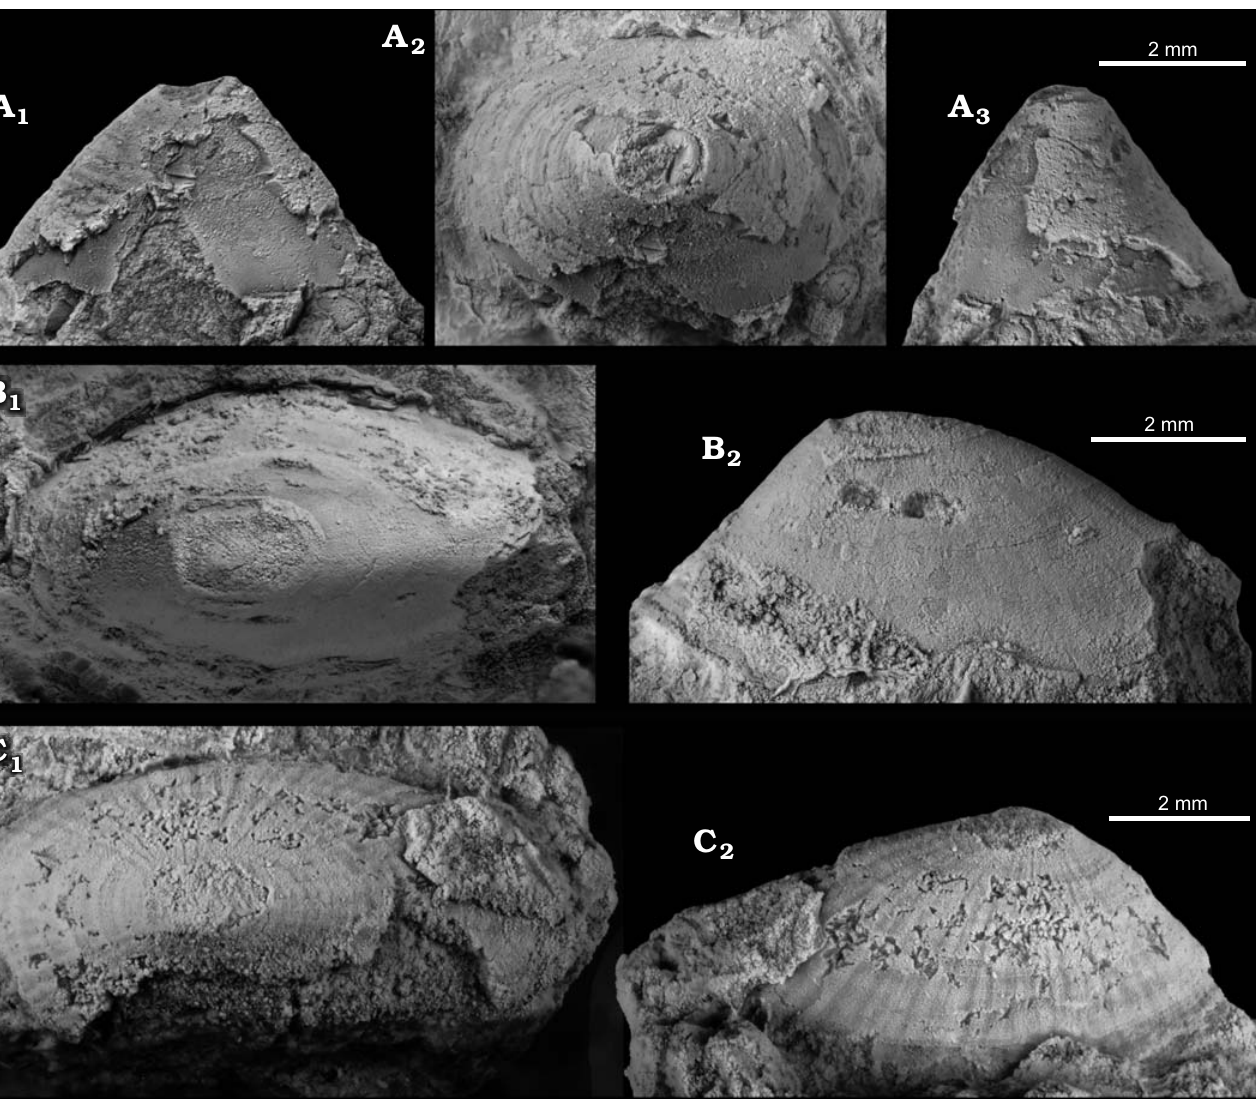
Fig. 9. Limpet gastropods from early Oligocene seep deposits at Cerro La Salina (block 6, B, C; block 9, A) Talara Basin, northern Peru. A . Limpet indet. 1 (NRM Mo187032) in lateral view (A 1 ), apical view (A 2 ) and seen from anterior view (A 3 ). B . Limpet indet. 2 (NRM Mo187033) in apical (B 1 ) and lateral (B 2 ) views. C . The cocculinid Coccopigya sp. (NRM Mo187034) in apical (C 1 ) and lateral (C 2 )